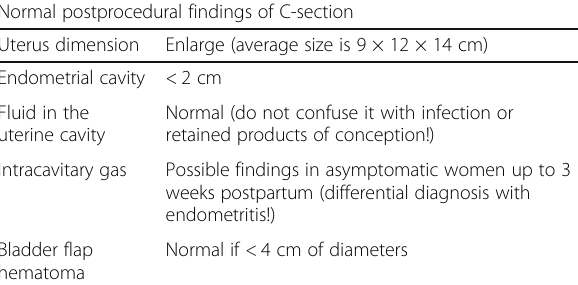
Table 1 Normal postprocedural findings [1] Normal postprocedural findings of C-section Uterus dimension